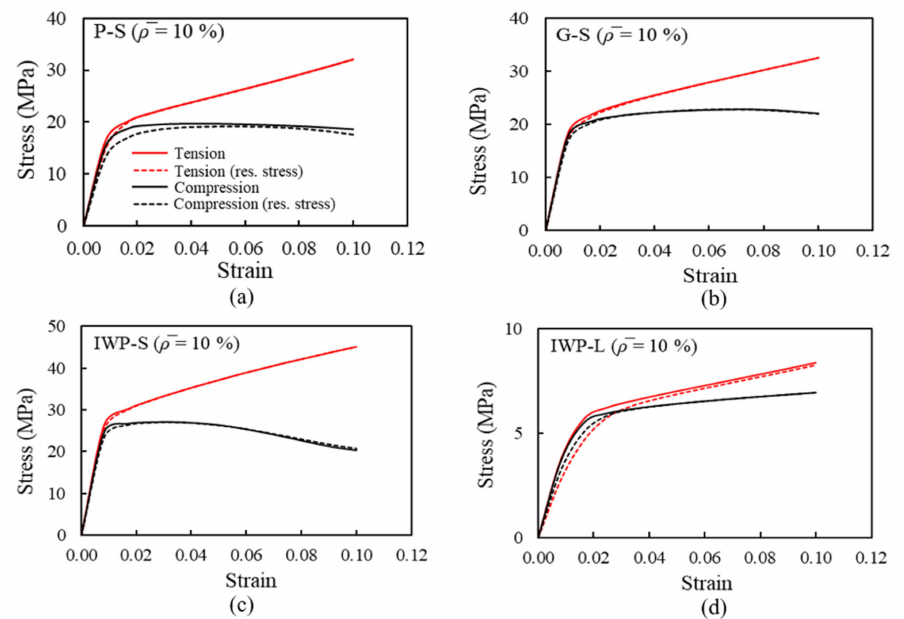
Figure 11. The stress–strain curve for tension/compression loading for ρ = 10% with and without residual stress: ( a ) P-S, ( b ) G-S, ( c ) IWP-S, and ( d ) IWP-L.